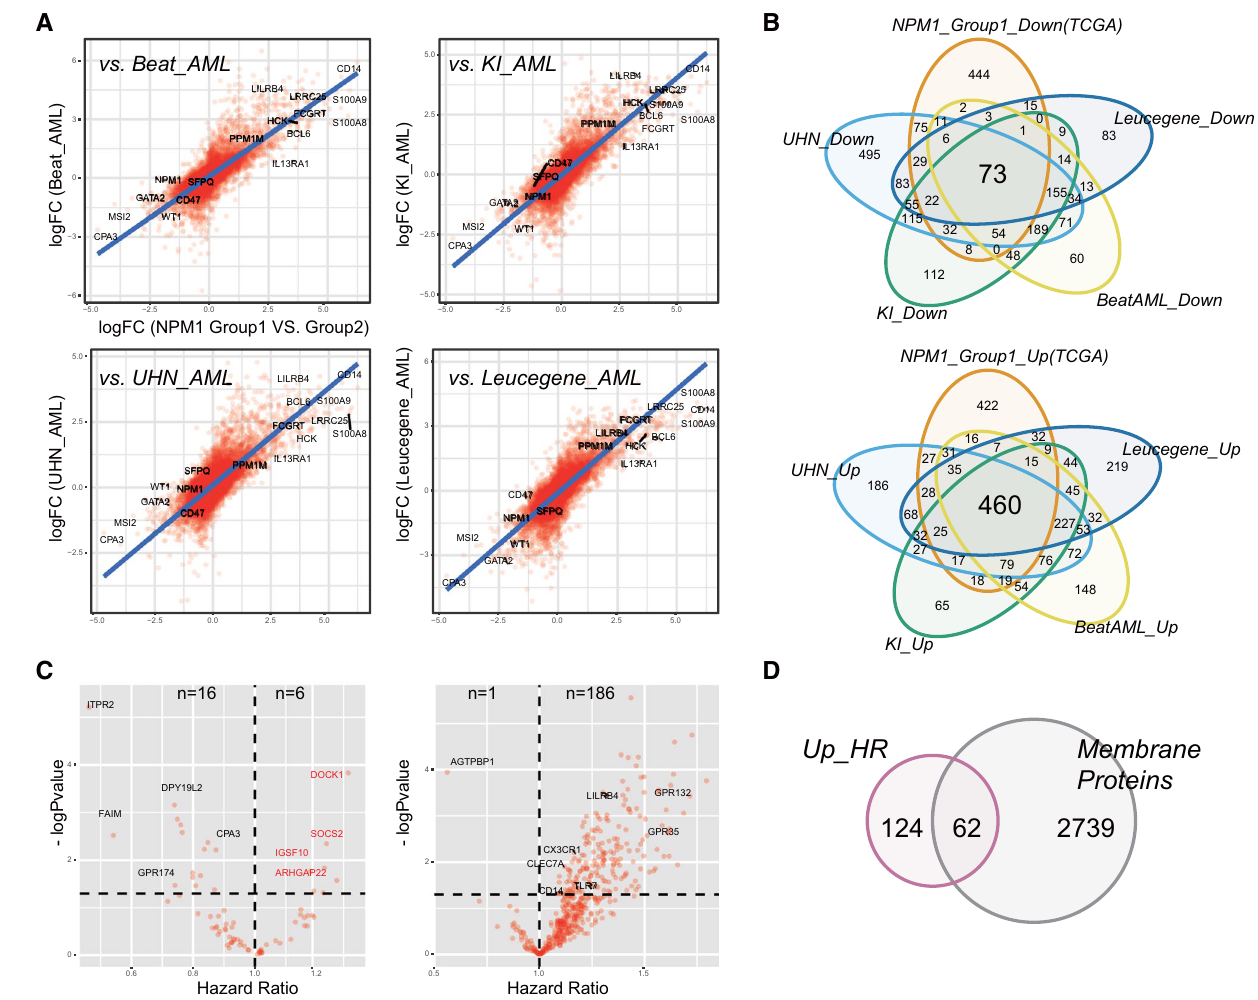
Fig. 4 Cross-cohort validation of dichotomy of NPM1 + AML patients and prioritization of essential genes in NPM1_Group1 by risk correlation and prognostic analysis. A Correlation plots of gene expression changes of transcriptomes from NPM1 _Group1 vs. Group2 comparison of TCGA_LAML datasets and from other sources of AML datasets: Beat_AML, KI_AML, UHN_AML and Leucegene_AML. Each red dot represents a gene. X-axis, logFC value from NPM1_Group1 vs Group2 comparison in the TCGA_LAML dataset; Y-axis, logFC value from the compari- sons in other four datasets respectively. The blue line is a linear regression fitting based on all gene’s logFC value. B Venn diagrams of up- regulated genes and down-regulated genes in the five AML datasets. Only DEGs with fold change > 2 or < -2 and p < 0.05 were included. C Volcano plots of co-downregulated and co-upregulated genes after Hazard Ratio (HR) analysis between gene expression level and survival status. Among 73 co-downregulated genes, 6 are positively correlated to AML patient survival while 16 are negatively correlated. Among 460 co-upregulated genes, 186 are positively correlated to AML patient survival while only 1 is negatively correlated. D A third of HR-related co-upregulated genes encode membrane proteins (Fig. 4C). Out of 460 upregulated DEGs, the HR value of 86 genes including CLEC7A , LILRB4 , CX3CR1 and GPR132 is greater than 1 and only 1 is smaller than 1 (Fig. 4C). Interestingly, one third of HR-related upregulated DEGs (n = 62) encodes membrane proteins, provide fertile resource for protein labeling and stratification by flow cytometry in the future (Fig.